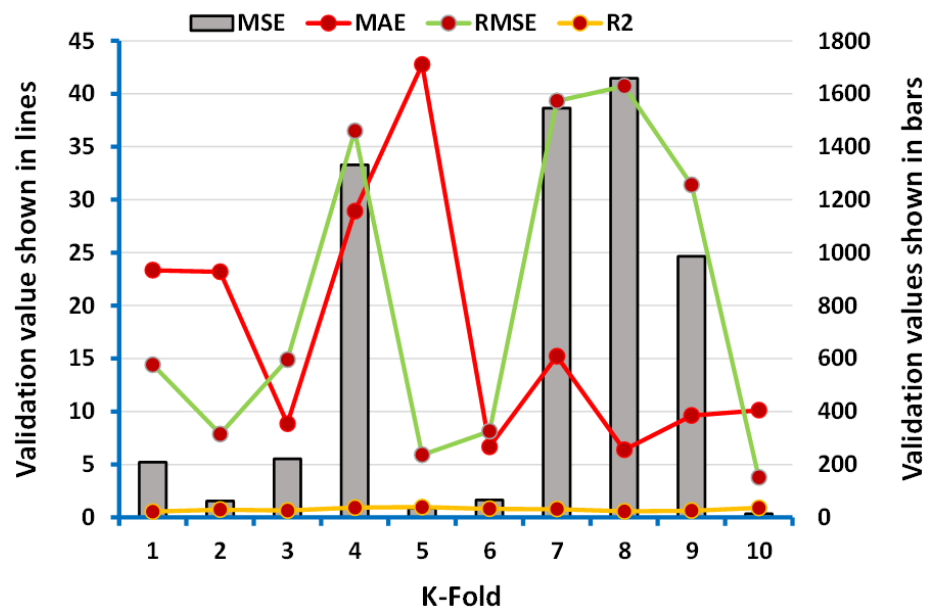
Figure 8. Representation of the statistics for k-fold cross-validation of the ANN model.